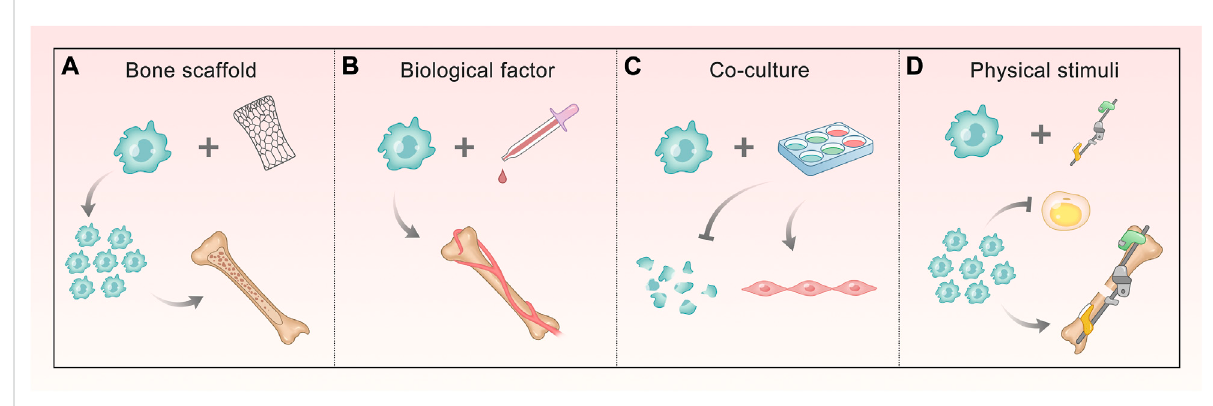
FIGURE 2 Methods of promoting ASC osteogenesis involving different signals. (A, B) Bone scaffold and biological factors involve BMP/Smads, Wnt/GSK- 3 β / β -Catenin, OPG/RANKL/RANK, and HIF-1a pathways. The former makes ASCs proliferate and form mineralized nodules, and the latter ensures ASCs mediate bone matrix formation and enhance vascular ingrowth. (C) Co-culture involves HIF-1a and TGF- β pathway, making ASCs decrease apoptosis and differentiate into vascular smooth muscle cells (VSMCs). (D) Physical stimuli correlate with Ca 2+ , integrin, PG, and NO signaling, which do ASCs a great favor in proliferating and attaching, enhancing osteogenesis and reducing the differentiation into